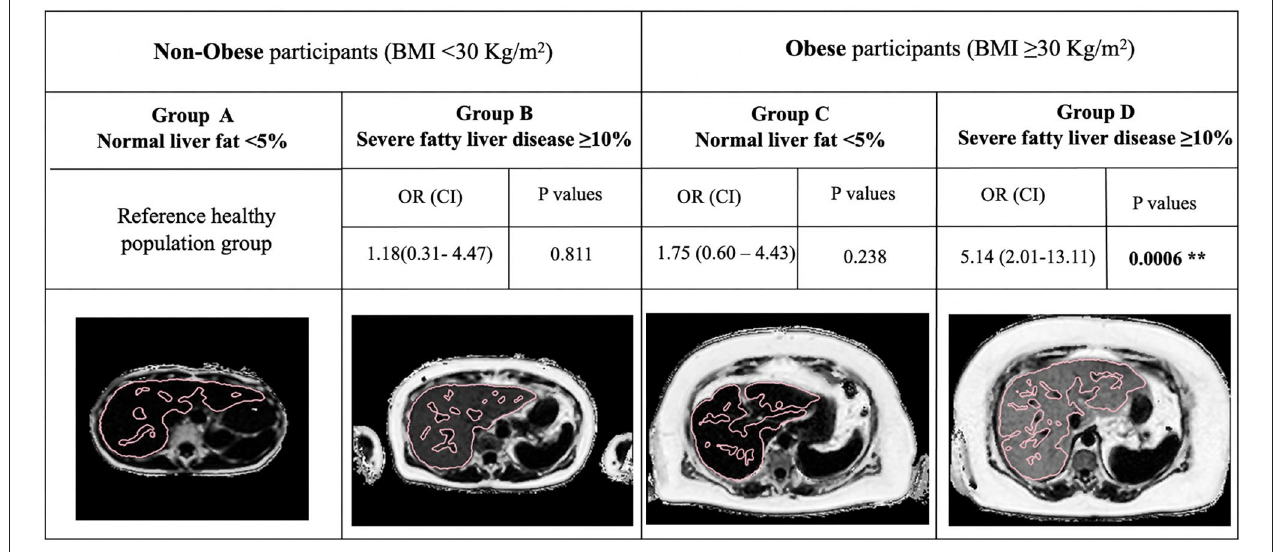
FIGURE 4 | Representative LiverMultiScan images from the UKB cohort, showing multivariate analysis of the “hepato-metabolic risk” variable. BMI < 30 Kg/m 2 and Liver fat < 10% was used as reference healthy population. Odds ratio and confidence intervals of the associations between obesity and liver fat are presented for hospitalized with a positive test result participants vs. non-hospitalized positive patients. BMI, body mass index; OR, odds ratio; CI, confidence interval. Significance is indicated by ** p ≤ 0.01. Reproduced by kind permission of UK Biobank ©